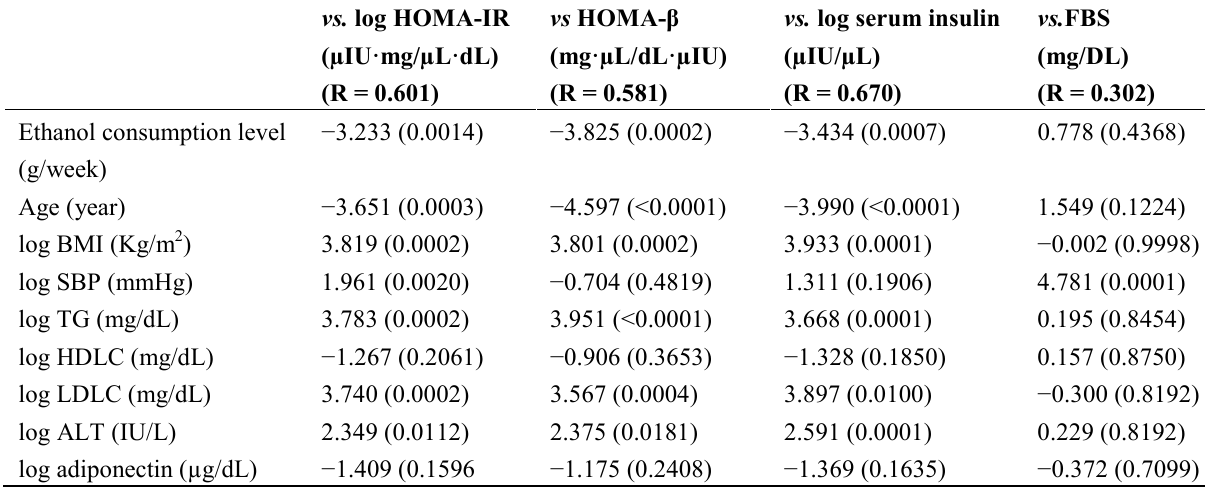
Table 2. Relationship between ethanol consumption level and HOMA-IR, serum insulin, or FBS assessed by multiple regression analysis; n = 371, t value (p